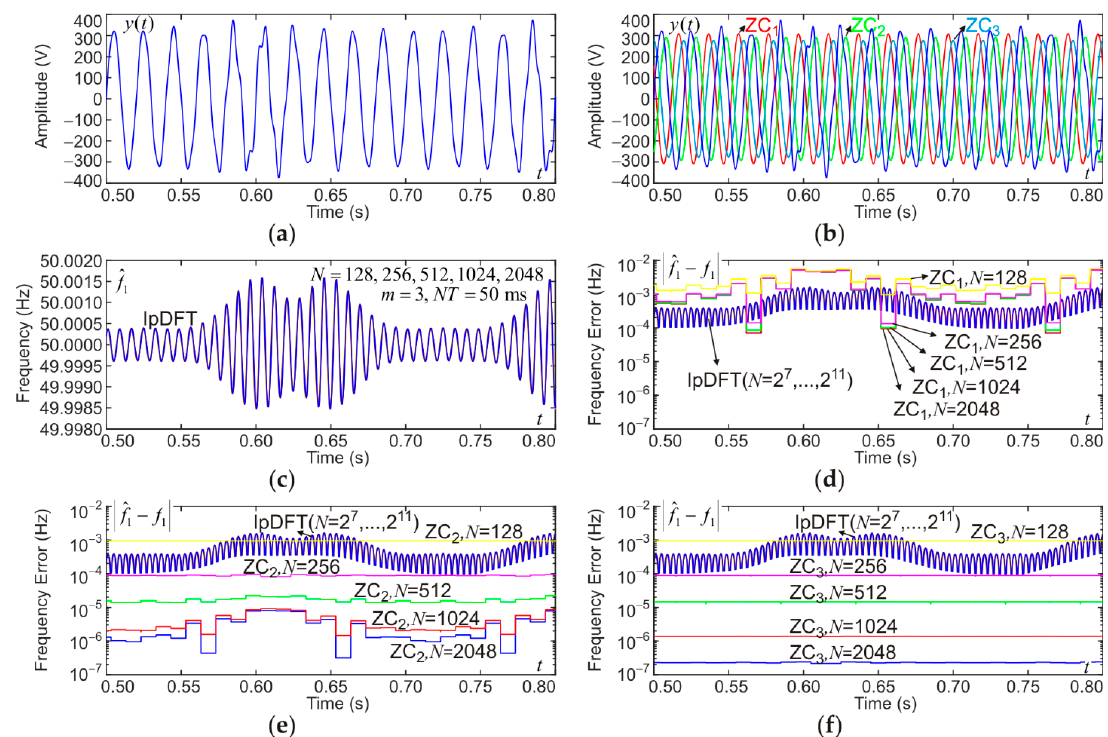
Figure 15. Effect of interharmonics on estimation results: ( a ) 50 Hz power network signal disturbed by interharmonics; ( b ) signals at the output of 6th-order (ZC 1 ), 12th-order (ZC 2 ) and 18th-order (ZC 3 ) filters for ZC; ( c ) IpDFT frequency estimation for m = 3 at a measurement time of 50 ms and for N = 128, 256, 512, 1024 and 2048; ( d – f ) comparison of the accuracy of the IpDFT method for m = 3 and NT = 50 ms with the ZC method for N = 128, 256, 512, 1024 and 2048 and for the 6th-order (ZC1), 12th-order (ZC2) and 18th-order (ZC3) filters.